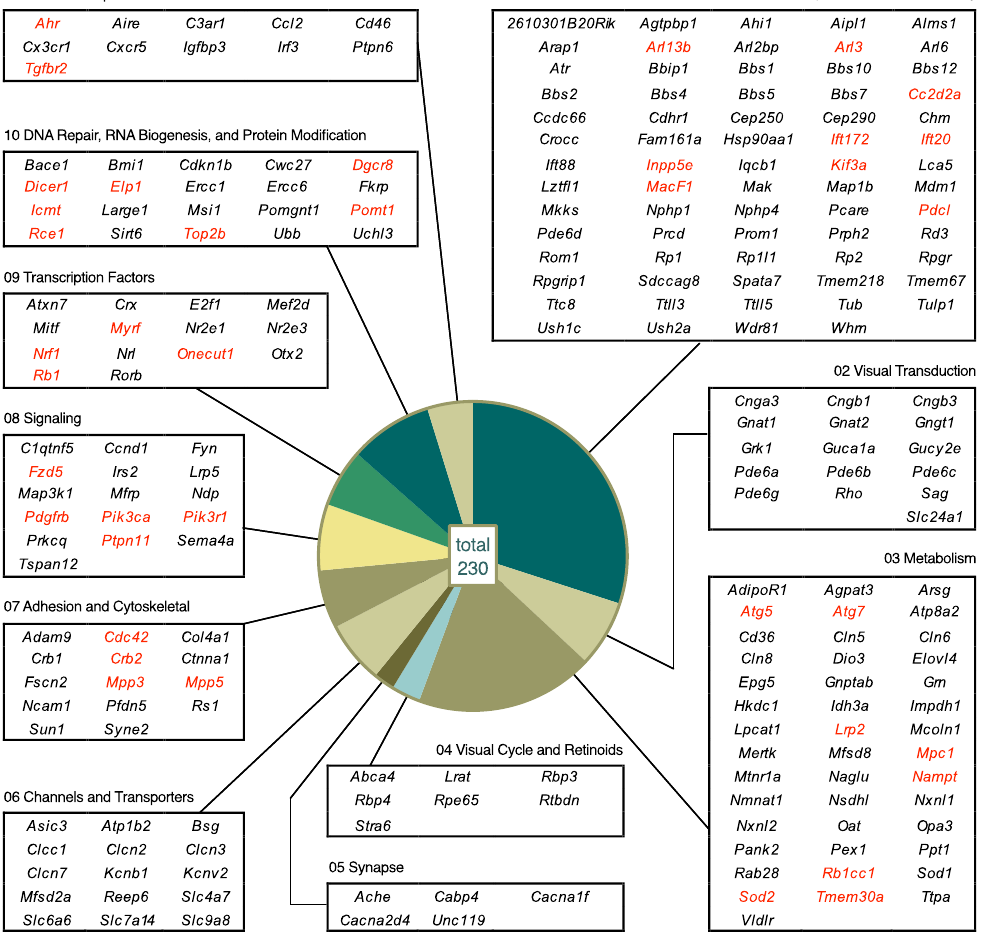
Figure 3. Genes associated with PR cell loss in monogenic mouse models of retinal degeneration (RD). Genes identified by combined review of the Mouse Genome Informatics (MGI) database and articles from a PubMed query were assigned to the indicated functional categories as described in the text. Genes for which mutant alleles are available only in the conditional form are displayed in red. Conditional alleles were included only in instances where germline null alleles resulted in embryonic, prenatal or postnatal lethality. For additional details on inclusion/exclusion criteria, see Section 3.4.